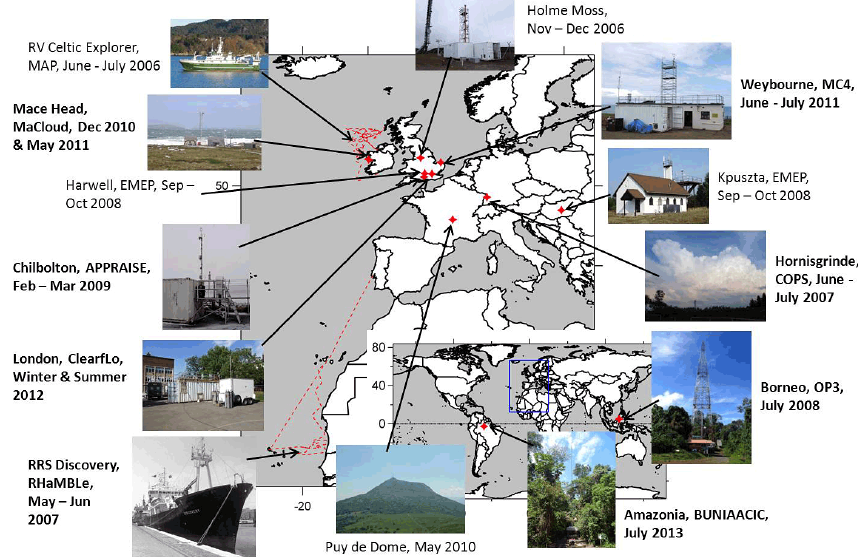
Figure 1. Map showing the locations of measurements. The labels name the locations, projects and dates of the experiments. The data sets used in this study are labelled in bold